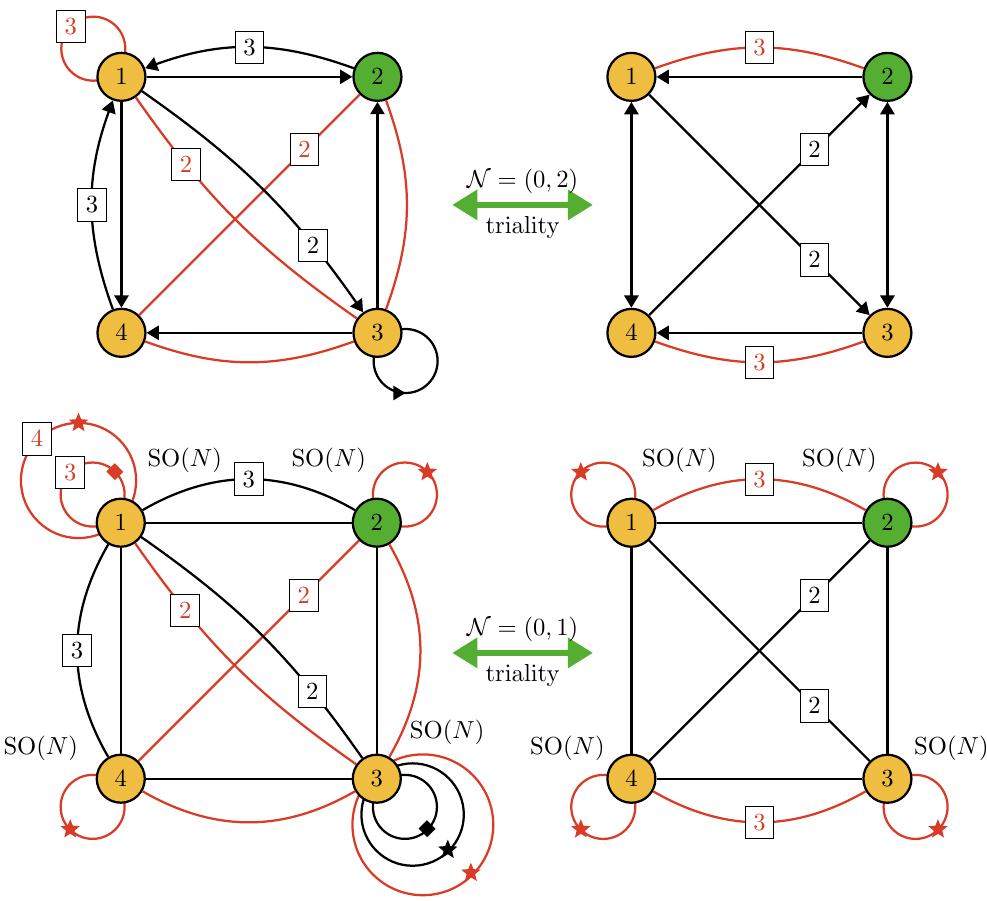
Figure 12 . Phases A and B of H 4 are connected by N = (0 , 2) triality on node 2 (shown in green). Upon orientifolding with the universal involution, the resulting theories are similarly connected by N = (0 , 1)